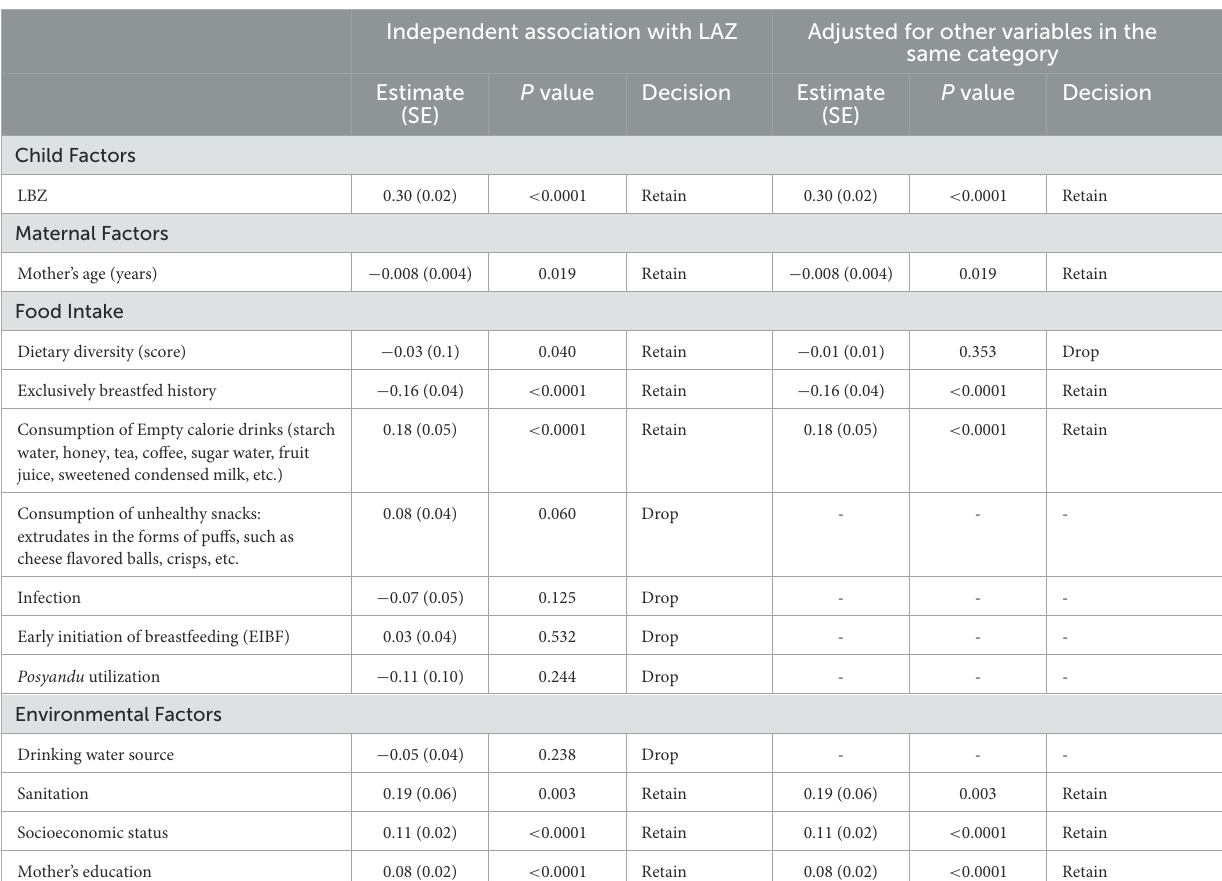
TABLE 3 Variable selection